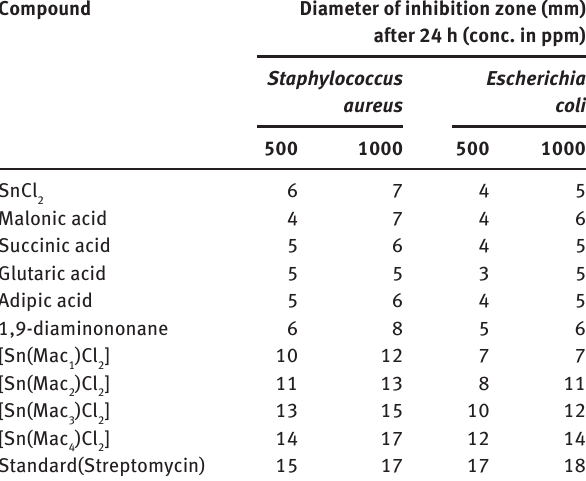
Table 5 Antibacterial screening data of tin(II) macrocyclic